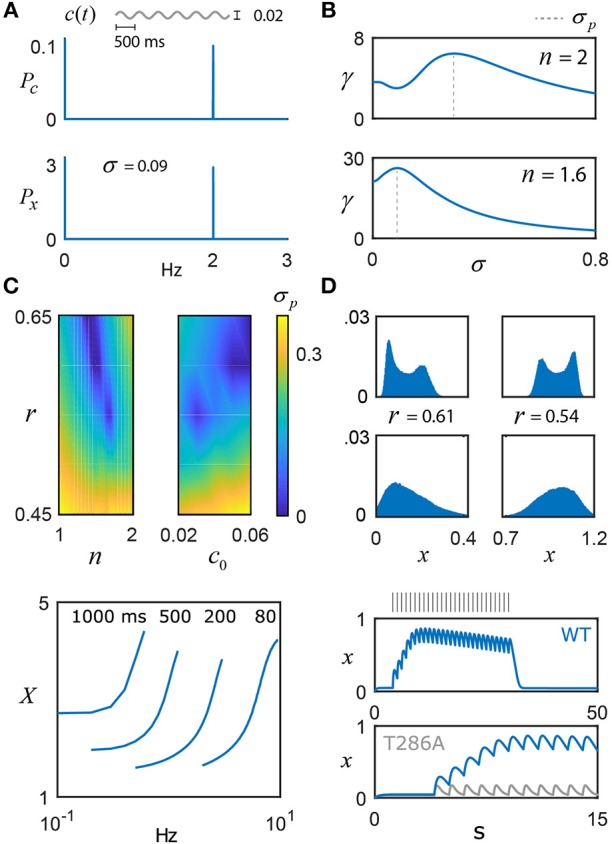
Frequency coding with noisy switches. (A) The switch model driven by a weak sinusoidal signal, c(t) = c0+αsin(2πφt), with c0 = 0.04, α = 0.02, φ = 2 Hz, and additive noise, η(t), whose intensity is scaled by the parameter σ and evolves according to τη = 0.01. The switch amplifies the frequency content of the input, as shown by its power spectrum Px relative to the signal's, Pc. (B)
Top: For n = 2, the ratio of switch power to signal power at φ is plotted as a function of the noise intensity σ, achieving a maximum at 0.29, that is, the switch displays stochastic resonance (SR). The value of σ that promotes optimal frequency transfer is denoted by σp. Bottom: For n = 1.6, there is substantially larger gain in the SR effect, and σp shifts to 0.09. (C) σp is plotted as a function of (n, r) and (c0, r), illustrating the presence or absence of SR. (D) For n = 1.6, stochastic switch simulations produce bimodal (e.g., σ = 0.01) or unimodal (e.g., σ = 0.035) activation around the low state (left column; r = 0.61, c0 = 0.04) and the high state (right column; r = 0.54, c0 = 0.04) (Box 1). Within each sub-state region, the input is uniquely encoded. (E) As model validation, the pulse duration (ms) and frequency experiments of De Koninck and Schulman were simulated (n = 1.6, r = 0.61, and T = 0.4), qualitatively capturing their results, as well as the results of a follow-up model (Dupont et al., 2003). The reader should note the ambiguity in autonomously activated (long timescale) switch activity, based on input duration and frequency (Pinto et al., 2012). (F) To validate the model against short timescale CaMKII data, a 1 Hz pulse train generates a calcium signal that drives the switch model: the top plot shows the entire period of stimulation and the decay of the switch after cessation of the stimulus (n = 1.6 and T = 0.1). These simulations qualitatively capture the exciting new experimental data of Chang et al. (2017). Note that, instead of a fixed value of negative regulation, r now linearly increases from 0.58 to 0.67 over the course of the stimulus, providing a potential explanation of the slow decay in the plateau switch concentration seen in the data but not in the model for a fixed value of r. The bottom plot zooms in on the first 15 s and also plots the model prediction for a T286A mutant form of CaMKII, which prevents the nonlinear switch activation. Naturally, this results in a much weaker response compared to the wild-type (WT), as seen in the data (Chang et al., 2017).